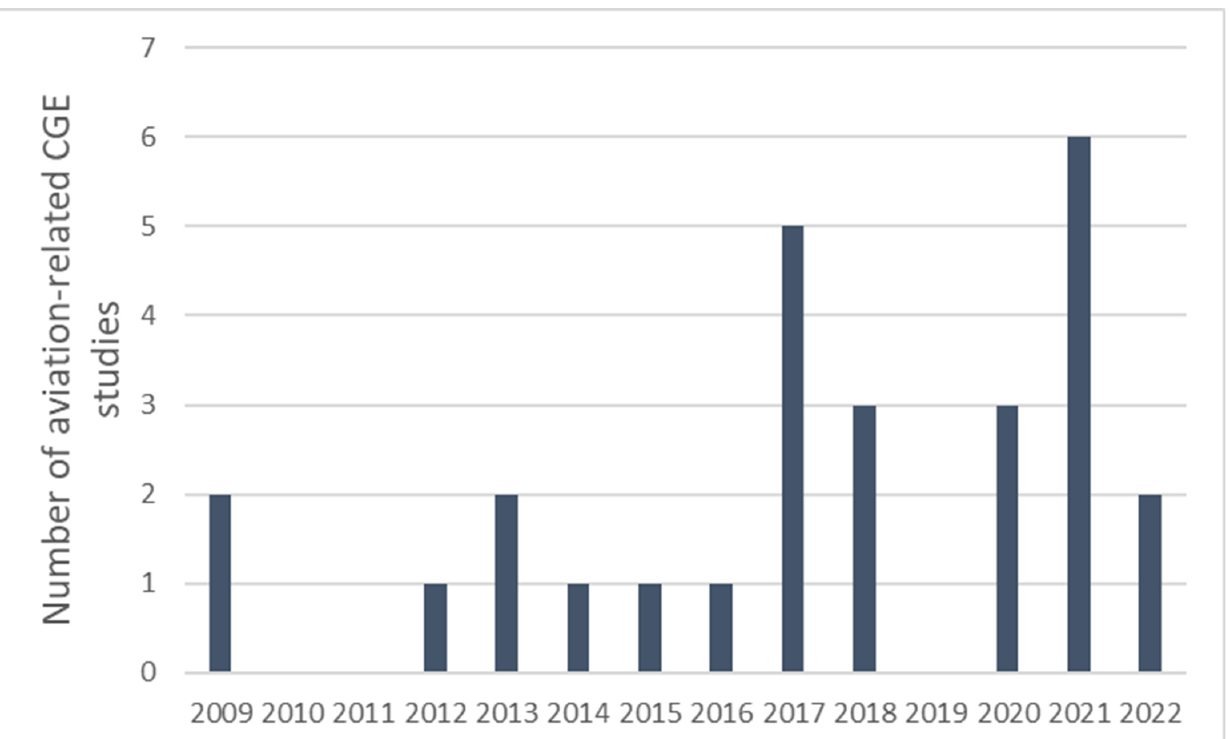
Figure 6. Number of computable general equilibrium models dealing with aviation, published per year.